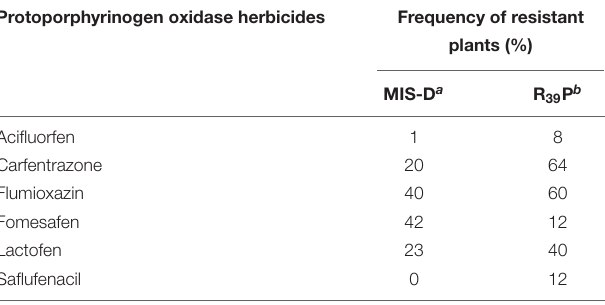
TABLE 3 | Response of PPO-resistant populations to the various foliar-applied protoporphyrinogen oxidase herbicides.